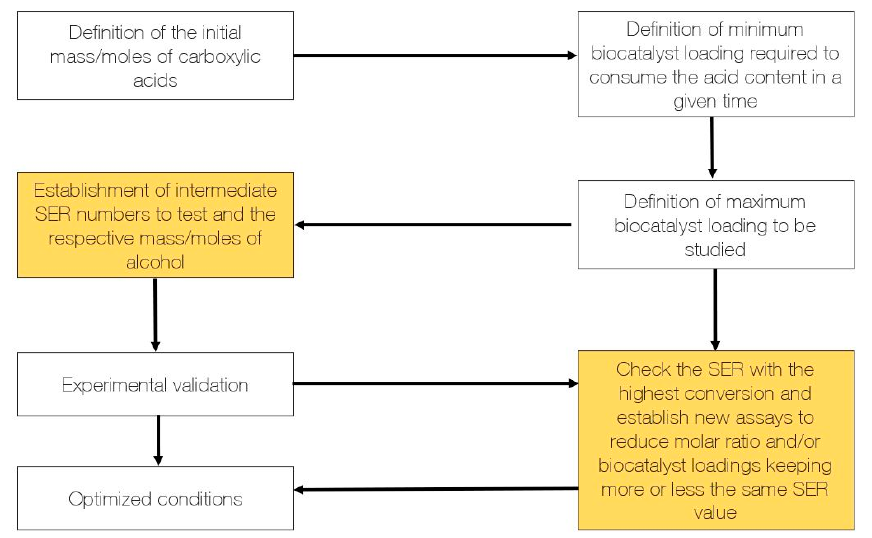
Figure 2. Fluxogram of steps required to design a set of experiments using SER. Table 4. Hypothetical experimental design for enzymatic esterification using SER.